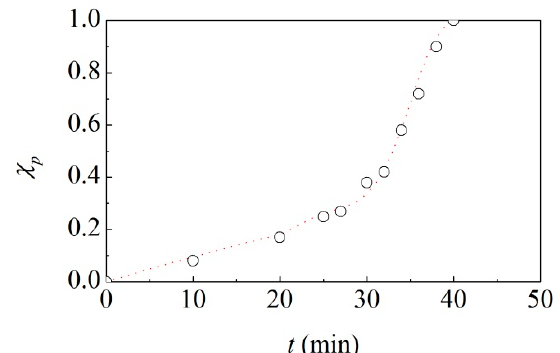
Figure 1. Kinetics of mechanochemical Knoevenagel condensation. The fraction of products, χ p , as a function of milling time, t . The best-fitted curve is shown.